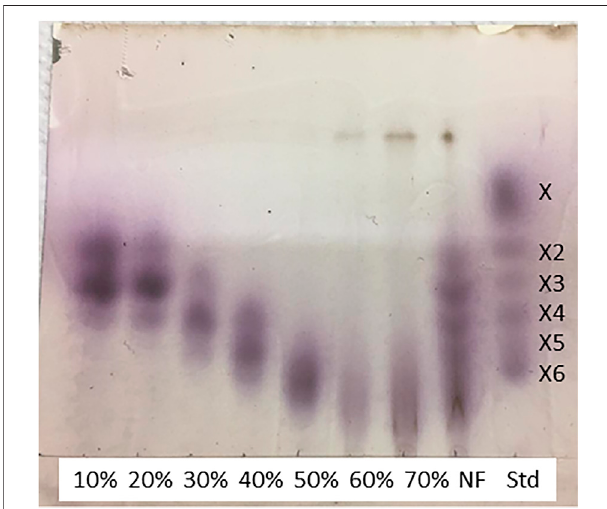
FIGURE 3 | Thin-layer chromatography elution of xylooligosaccharides contained in the GAX extract that remained soluble in 90% (v/v) ethanol, as described in Table 2 . Soluble material was adsorbed in active charcoal and desorbed by increasing ethanol concentrations. Each fraction is identi fi ed by the ethanol concentration used in the desorption step. NF is the non-fractionated original sample; Std refers to xylooligosaccharide standards eluted in the same run.